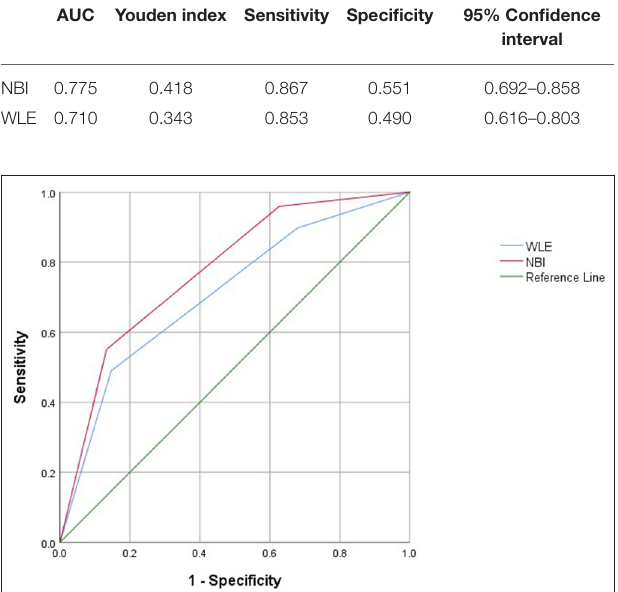
TABLE 7 | Area under an ROC curve, sensitivity, specificity, and Youden index for defined endoscopic and clinical recurrence in patients with UC.